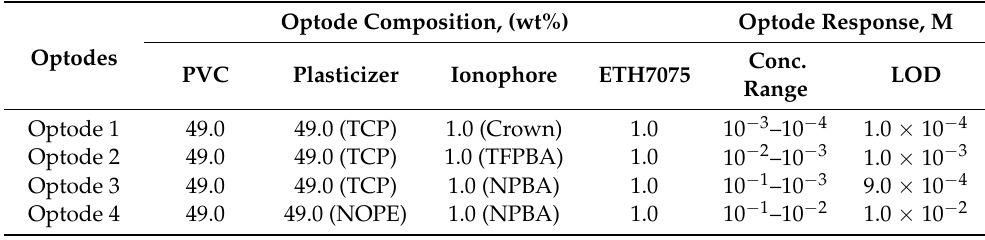
Table 1. Composition of the prepared optode membranes and their response characteristics towards